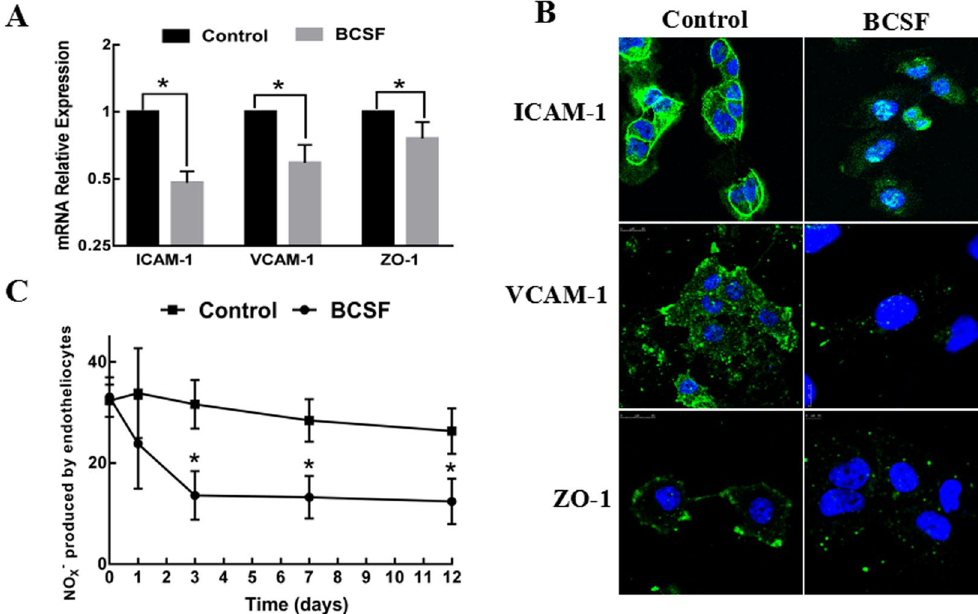
Figure 2. The effect of BCSF on endothelial function. ( A ) The mRNA expression of ICAM-1, VCAM-1 and ZO-1 was markedly reduced in BMECs treatment with BCSF for 24 h ( p < 0.05). ( B ) The immunofluorescent staining showed that the BCSF group had weak signal of the tight junction protein ZO-1and the adhesion molecules ICAM-1, VCAM-1on cell membrane surface. ( C ) The NO X- production was also significantly decreased after BCSF treatment, the greatest reduction especially in the 3rd